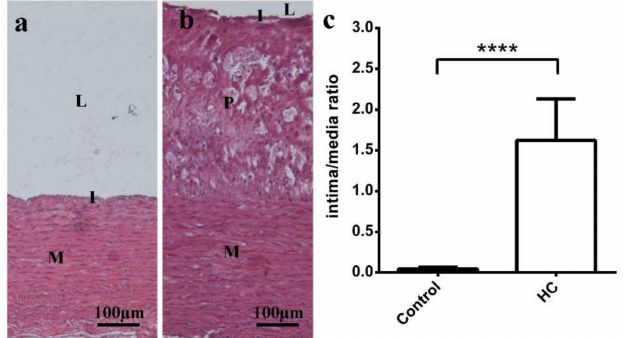
Figure 2. Histological analysis of aortic sections. ( a ) shows a healthy control sample with intact endothelium. Foamy atherosclerotic plaque observed in HC animals is shown on panel ( b ). Graph ( c ) demonstrates intima/media ratio, which was significantly increased in HC group compared to Control